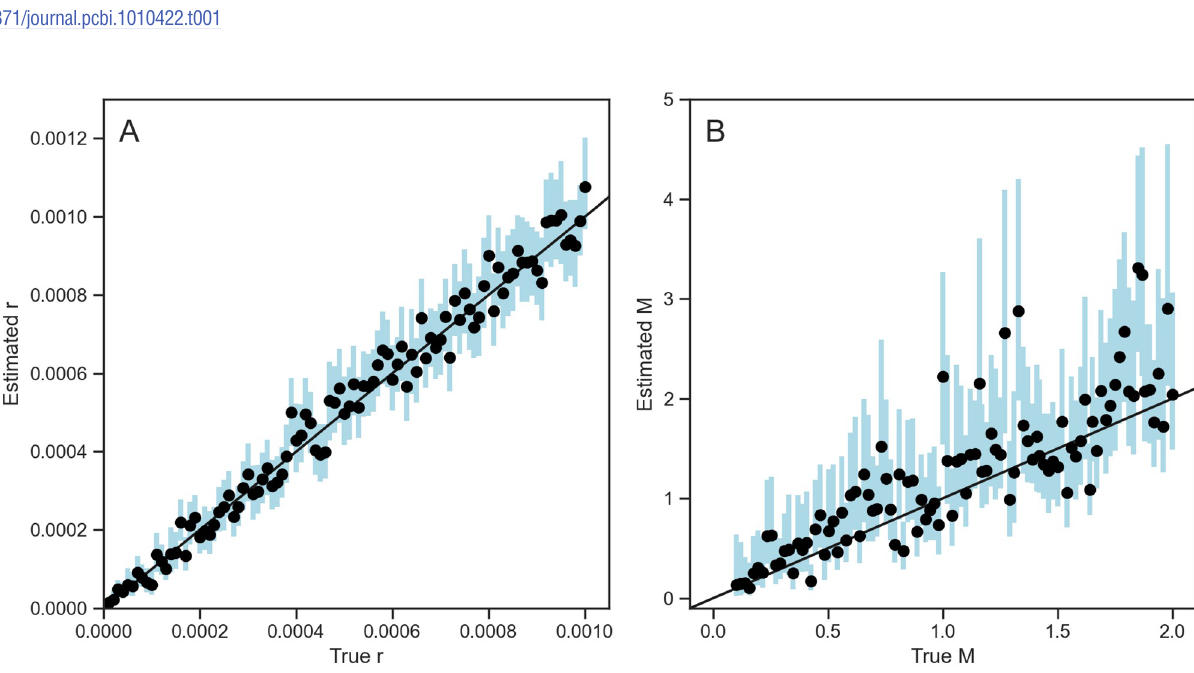
Table 1. The relative bias, coverage, and calibration of estimating N , r , M by the SCAR model. e Parameter Relative error Coverage Calibration N e +1.23% 92 in 100 times 0.98 r +1.87% 97 in 100 times 0.98 M +22.36% 95 in 100 times 0.85 Except for the parameter being systematically varied, all parameters were fixed at constant values: effective population sizes Ne = 1.0, sample sizes k = 100, genome